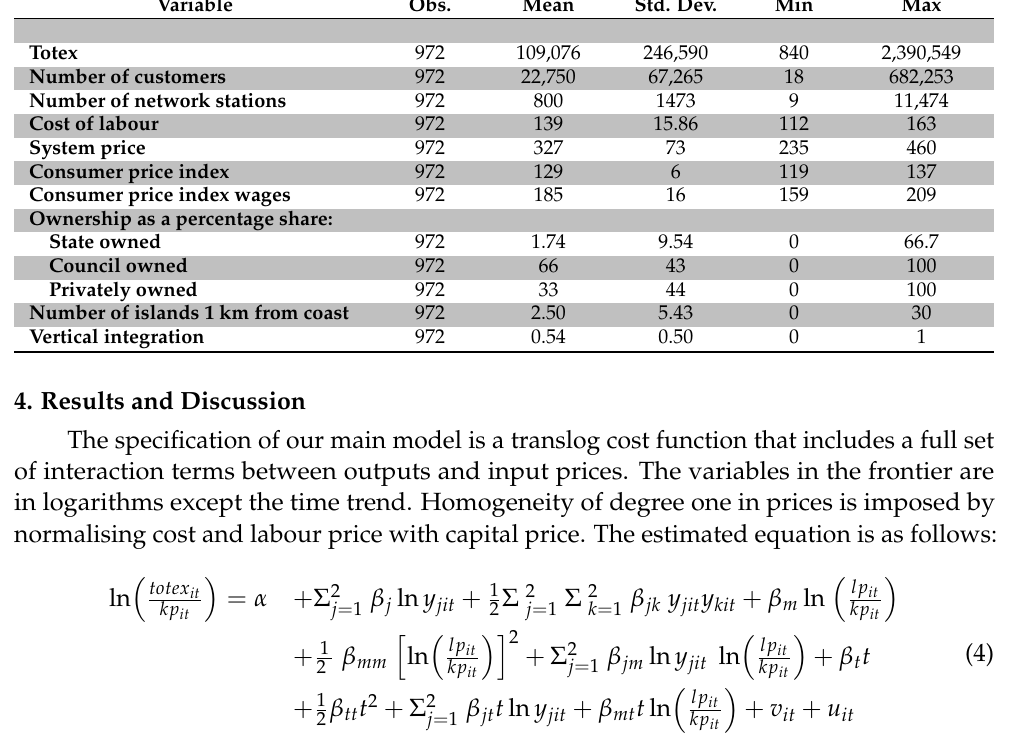
Table 1. Descriptive statistics.